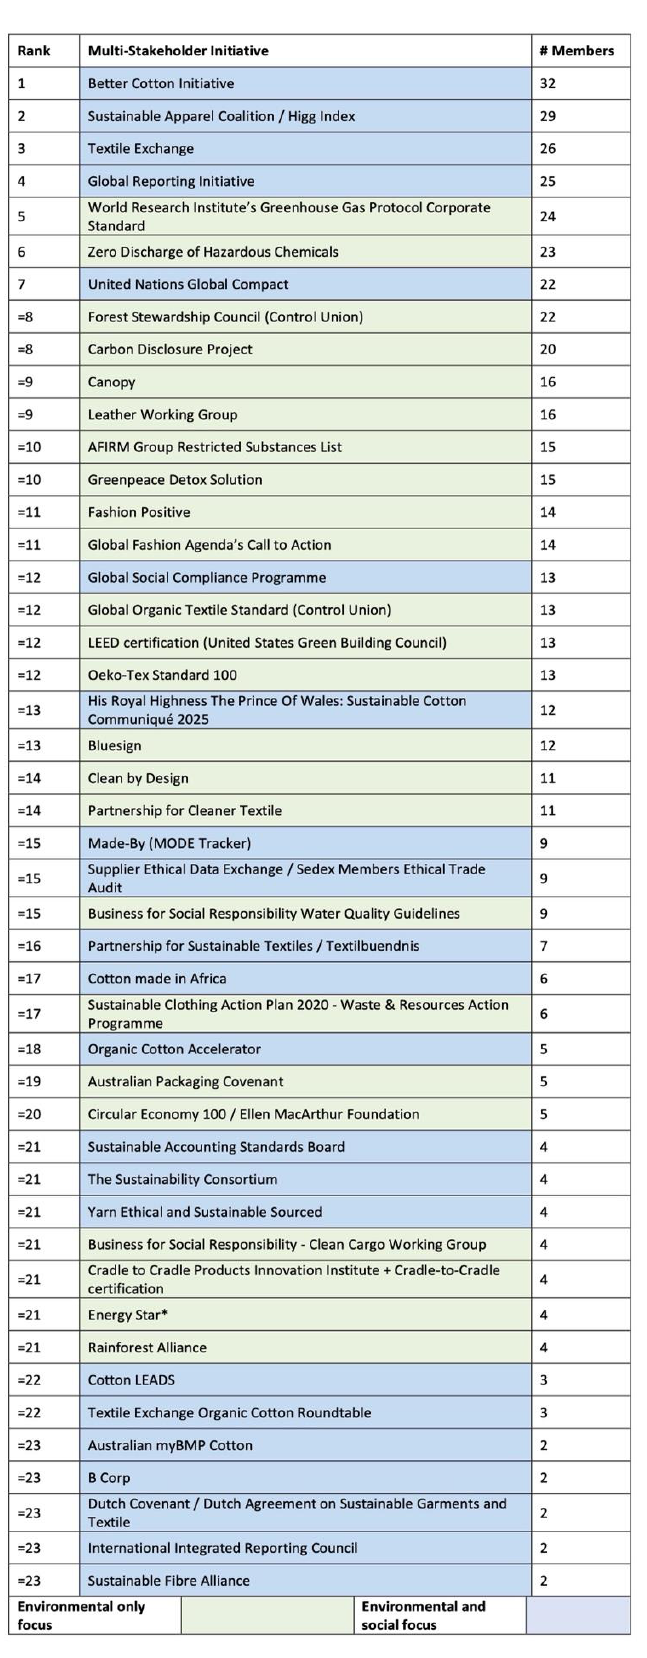
Table 2. MSIs mapped to retailer membership,